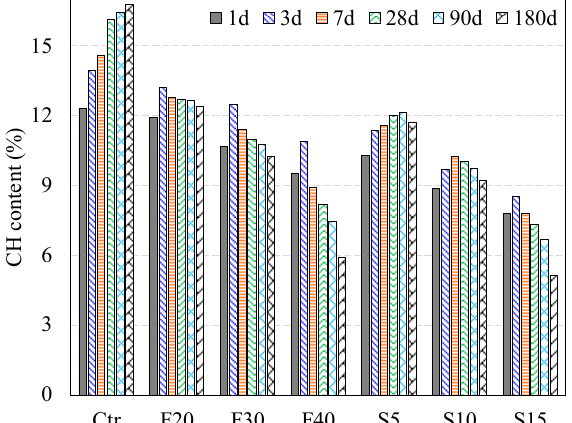
Figure 5. CH content in PC control and binary blended paste systems with w/b of 0.3, mist cured, at various ages.